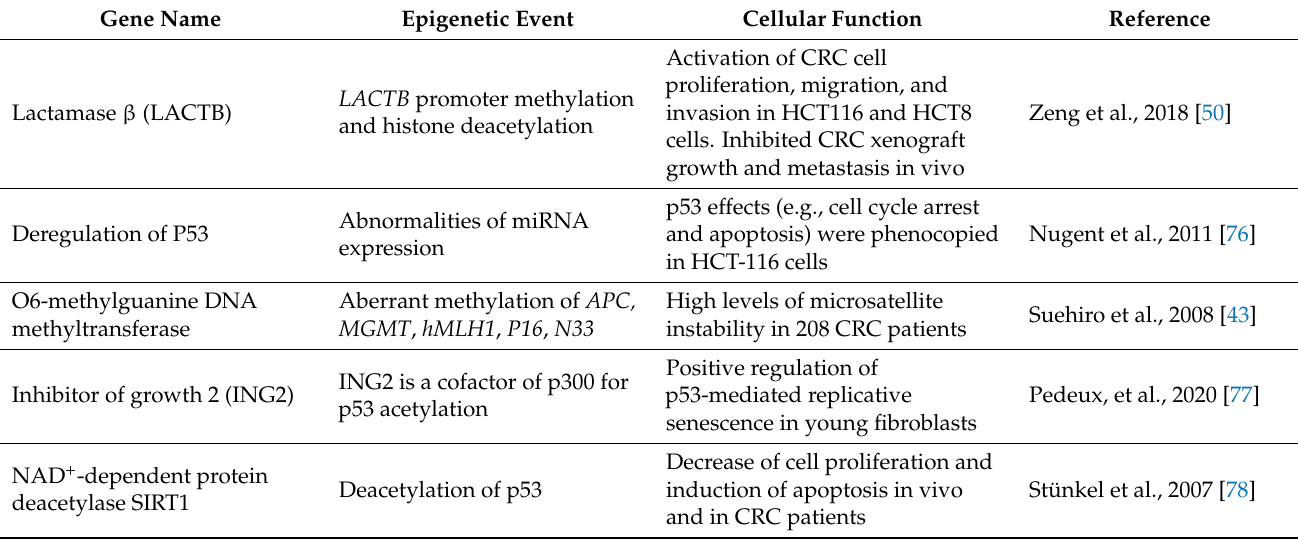
Table 2. In vitro and in vivo studies on epigenetics of p53 in